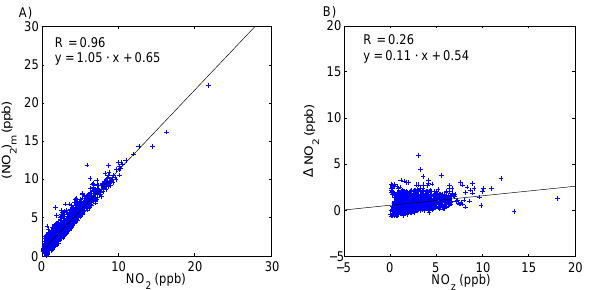
Fig. 7. Diurnal trend in ratio of ( NO 2 ) m to NO 2 measured from 1 June to 10 September, 2007 at Bear Creek, Ontario, a rural site located approximately 60km northeast of downtown Detroit, MI. ( NO 2 ) m denotes NO 2 measured by heated molybdenum catalyst chemiluminescence monitor, which can suffer from interference due to reducing non-NO 2 oxidized nitrogen species. True NO 2 was measured by a collocated photolytic converted chemiluminescence monitor, which reduces NO 2 selectively. Solid line represents me- dian ratio for that hour. Dotted lines represent 5th and 95th per- centiles. Hours are Eastern Standard Time. OMI overpasses occur between 12:00 and 14:00EST, which display some of the highest average